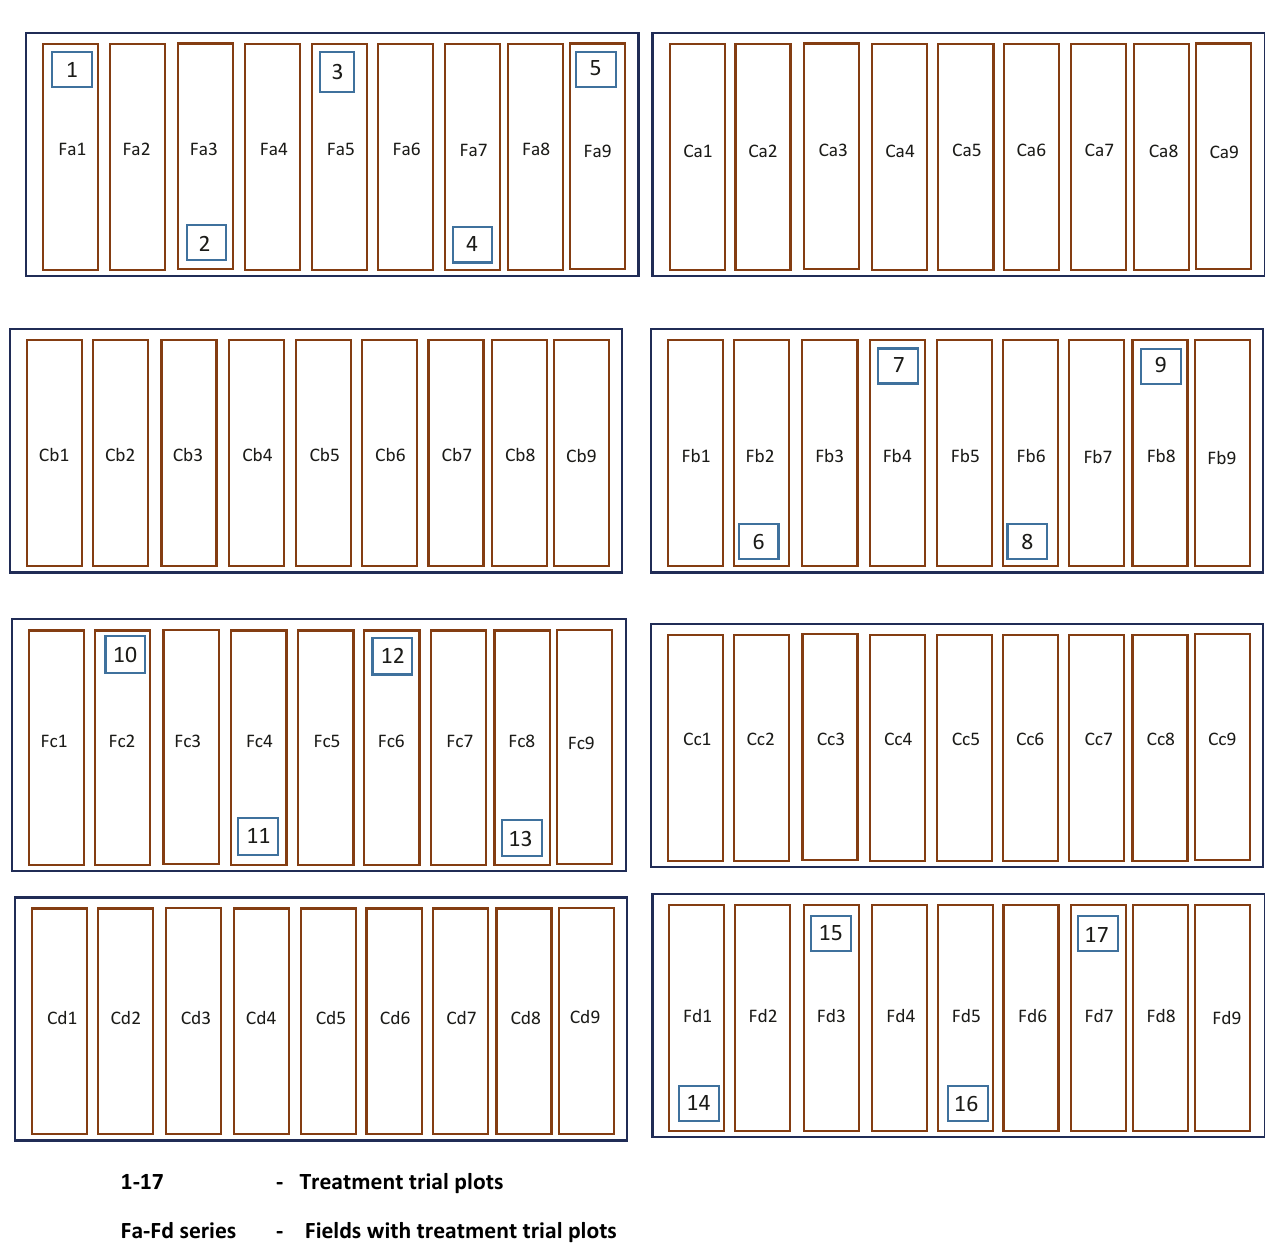
- Treatment trial plots Fa-Fd series - Fields with treatment trial plots Ca-Cd series - Fields with control plot * For every cropping cycles the alternative fields and the opposite plots were